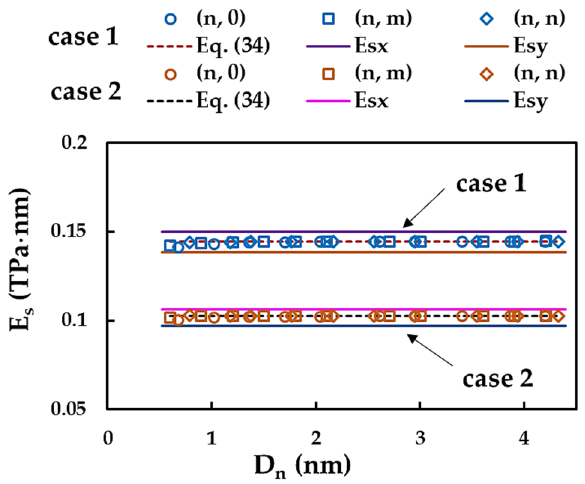
Figure 12. Evolutions of the surface Young’s modulus, E S , for SWInNNTs as a function of the nanotube diameter, D n , for Cases 1 and 2 of input parameters. The surface Young’s moduli, E sx and E sy , for InNNSs are also plotted for comparison purpose.